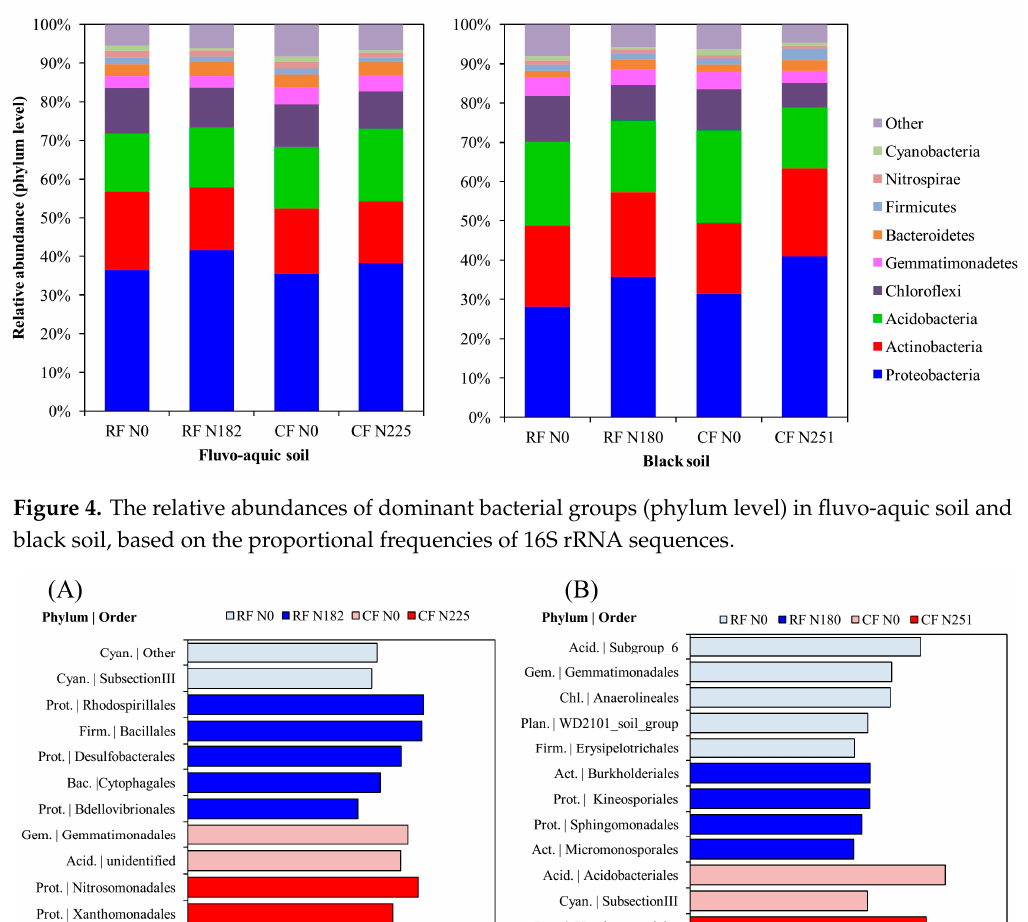
Figure 4. The relative abundances of dominant bacterial groups (phylum level) in fluvo-aquic soil and black soil, based on the proportional frequencies of 16S rRNA sequences.